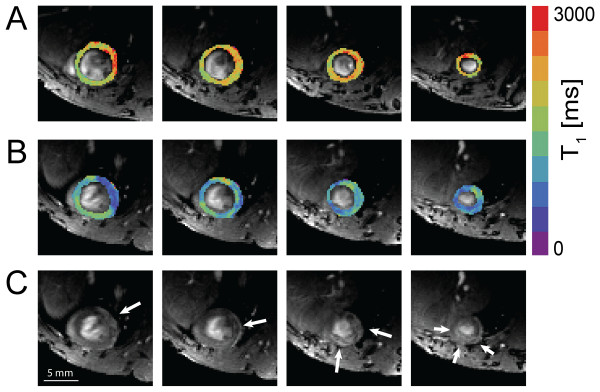
Pre-contrast myocardial T1 (A), post-contrast myocardial T1 (B), and post-contrast T1-weighted images (C) in a mouse with myocardial infarction. Arrows mark infarct regions showing contrast enhancement in post-contrast T1-weighted imaging. Images represent the same slices as in Figure 1.